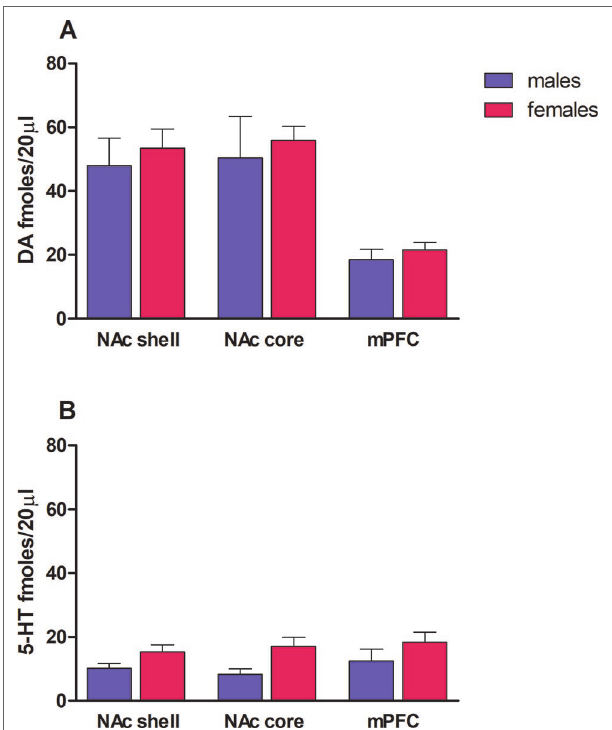
FIgURe 1 | Rat dopamine (A) and serotonin (B) basal levels in both male ( blue bars ) and female ( magenta bars ) rats. Results are expressed as the mean ± SEM of change in DA/5-HT extracellular levels expressed as fmol/20 μl sample in nucleus accumbens (NAc) shell, NAc core, and mPFC.